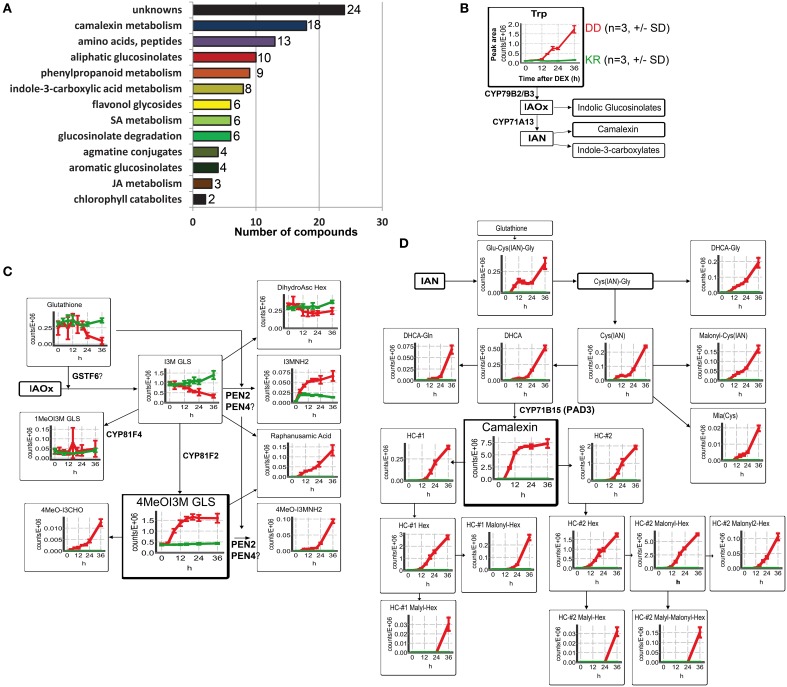
Modulation of metabolic defense response upon phosphorylation of MPK3/6. Wild type Col-0 DD and control plants were harvested 0–36 h after DEX treatment and methanolic extracts from leaves were analyzed by UPLC/ESI-QTOF-MS in both positive and negative mode. (A) Classification of the annotated metabolites. (B) General scheme of the biosynthesis of tryptophan (Trp)-derived metabolites. Change in levels of the precursor, Trp, is shown as mean of peak area ± standard deviation (SD) of three biological replicates. Accumulation kinetics for the control plants (Col-0 KR) are in green and for Col-0 DD in red. (IAOx = indole-3-acetaldoxime; IAN = indole-3-acetonitrile). (C) Changes in the levels of indolic glucosinolate (GLS) metabolites derived from IAOx are depicted as described in (B). (D) Changes in the levels of metabolites derived from IAN, i.e., camalexin derivatives and precursors. (HC, Hydroxycamalexin; DHCA, Dihydrocamalexic acid. For other abbreviations, see Table S1). Note that for all the graphs in (B–D), the y-axis represents the relative abundance of the metabolites (peak area of the quantifier ion, Table S19) and the x-axis the time (hours, h) after DEX treatment.